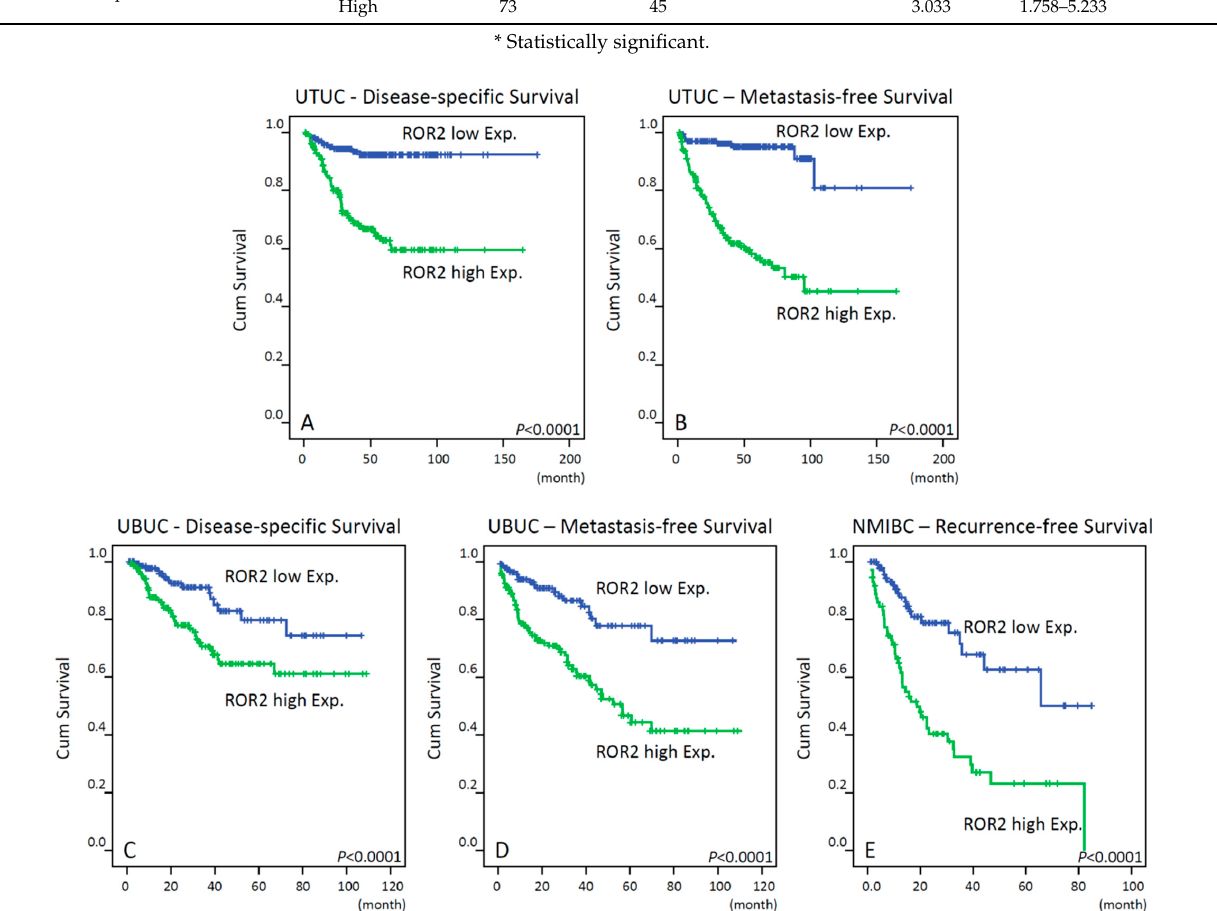
Figure 3. Kaplan–Meier survival analysis shows that ROR2 overexpression has significant prognostic impacts in disease- specific survival, metastasis-free survival, and bladder recurrence-free survival of patients with UTUC ( A , B , respectively) and UBUC ( C , D , respectively) and bladder recurrence-free survival of patients with NMIBC ( E ).